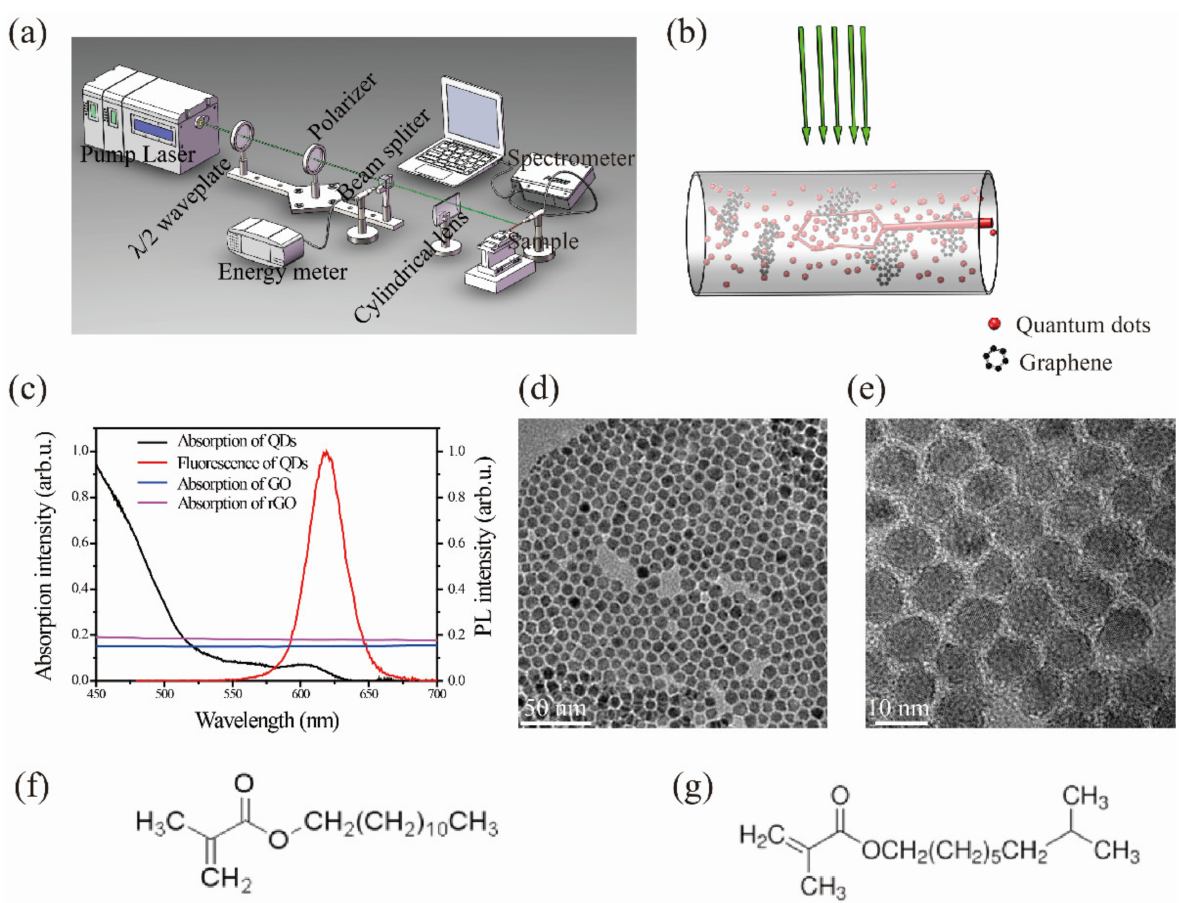
Figure 1. ( a ) Experimental setup for acquiring emission spectra of the samples, ( b ) schematic of the multiple light scattering within the samples, ( c ) absorption and PL spectra of samples, ( d , e ) transmis- sion electron microscope images of ZnCdSeS/ZnS quantum dots, ( f , g ) monomer structures before